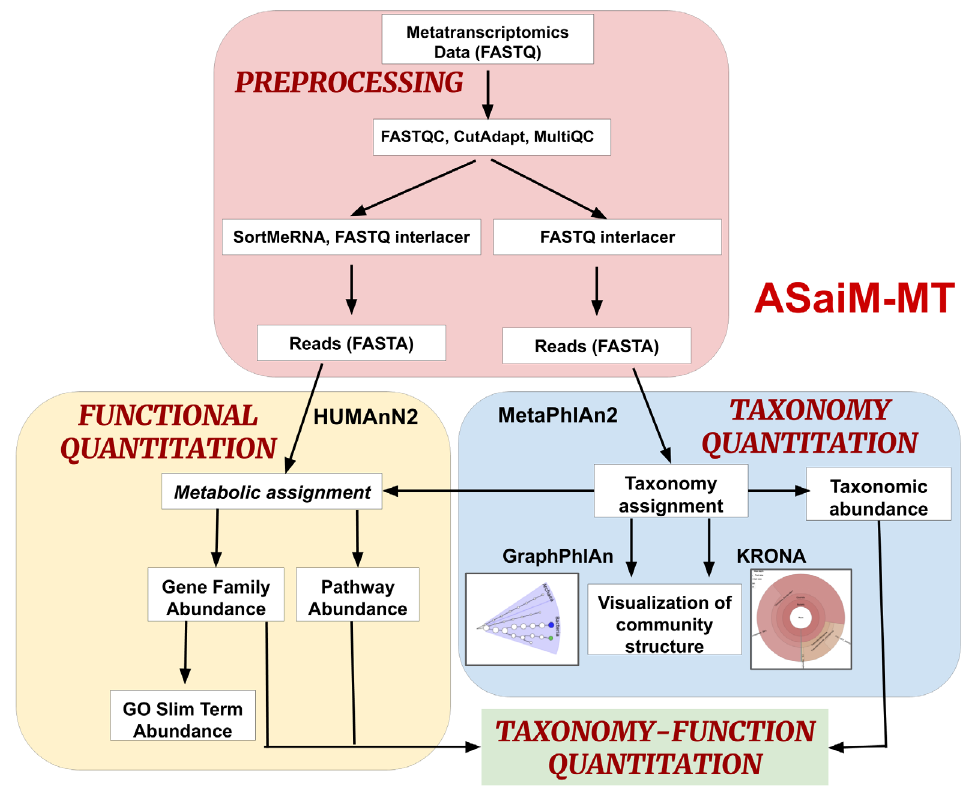
Figure 1. ASaiM-MT workflow: The workflow is divided into 4 parts. (i) Preprocessing: Process raw metatranscriptomics data to perform further analysis. (ii) Taxonomy Quantitation: Assignment of taxonomy along with abundance values and visualization. (iii) Functional Quantitation: metabolic assignment of identified functions and gene and pathway abundance annotation. (iv) Taxonomy-Function Quantitation: combine taxonomy and functional quantitation values into relative abundance values at different levels such as e.g., the abundance of a pathway between